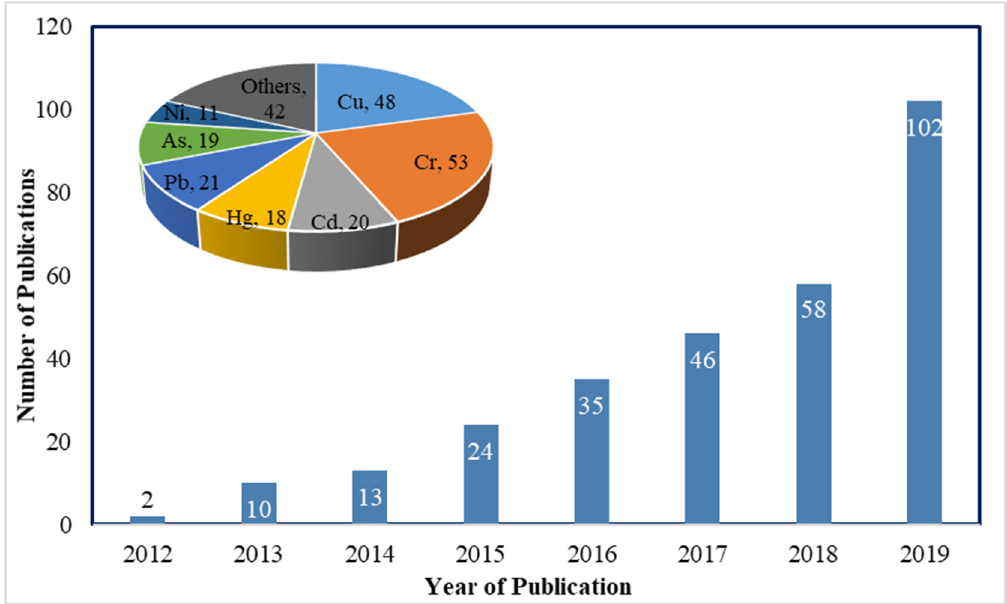
Figure 1. Annual publications returned using “graphene” and “metal removal” as keywords from ScienceDirect. Inset: the number of publications on removal of specific metals.